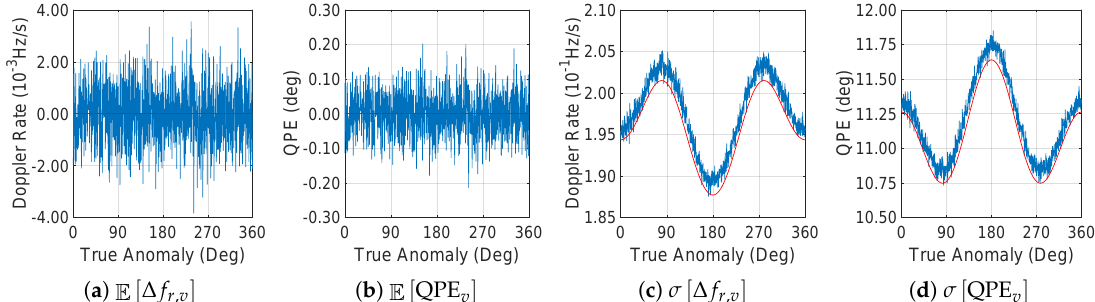
Figure 2. Velocity vector term: numerical simulation results (blue) and analytical approximation results (red). The figures show that the results from the analytical approximation model are consistent with the numerical simulation results. ( a , b ) The expected values have no significant relationship with the variation in the true anomaly and are positioned at a relatively low level, i.e., around zero. The differences between the two sets of results in ( c , d ) are due to the ignored terms in the approximation